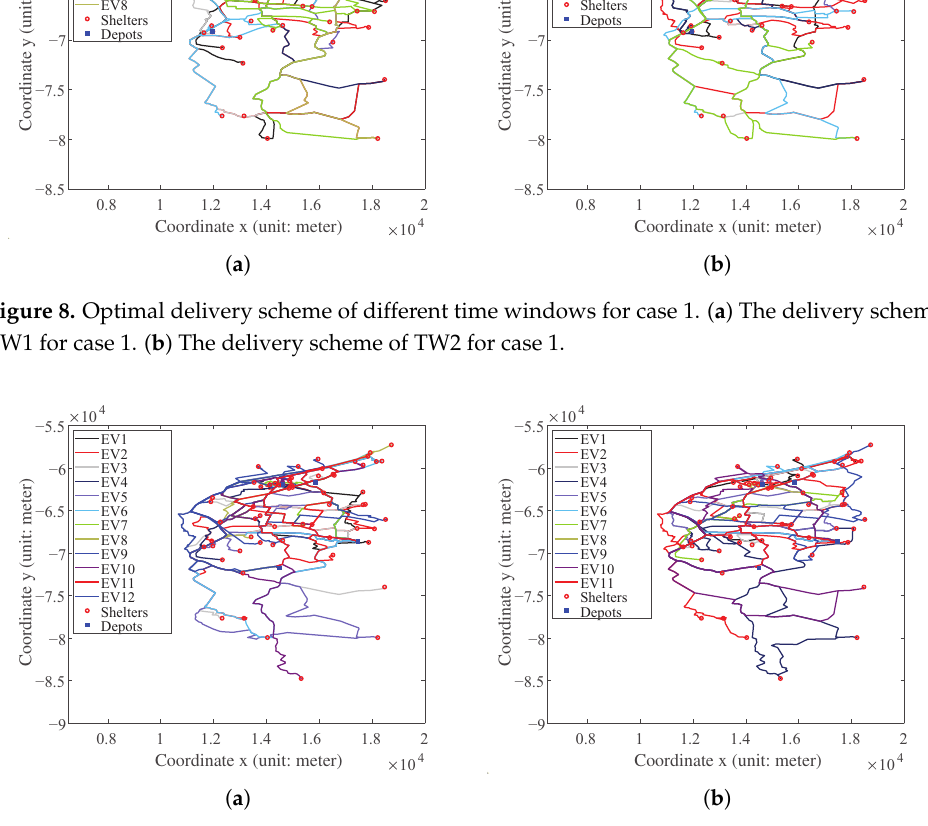
Figure 9. Optimal delivery scheme of different time windows for case 2. ( a ) The delivery scheme of TW1 for case 2. ( b ) The delivery scheme of TW2 for case